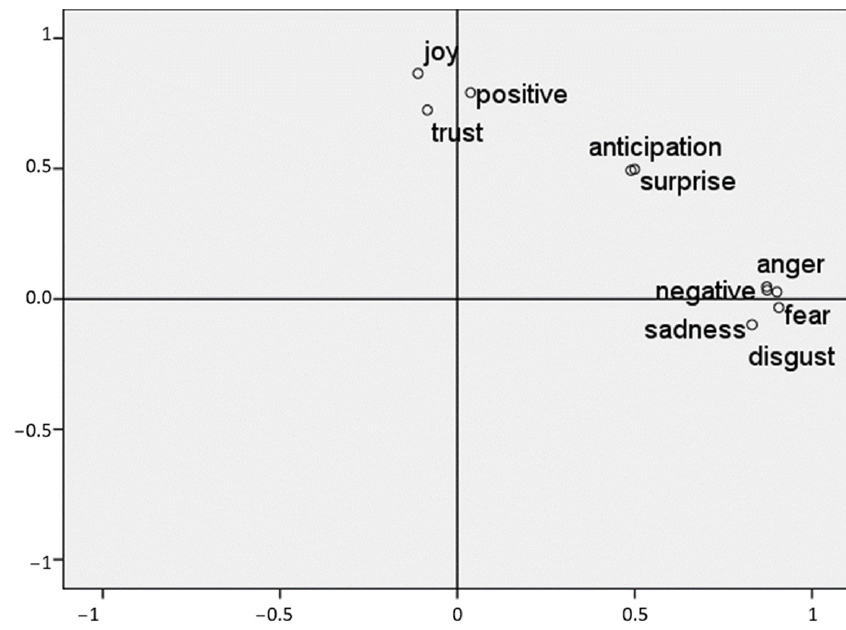
Figure 16. Relationships between the components extracted in the FA , period 2. Table 4. Total explained variance and goodness-of-fit test in period 2.